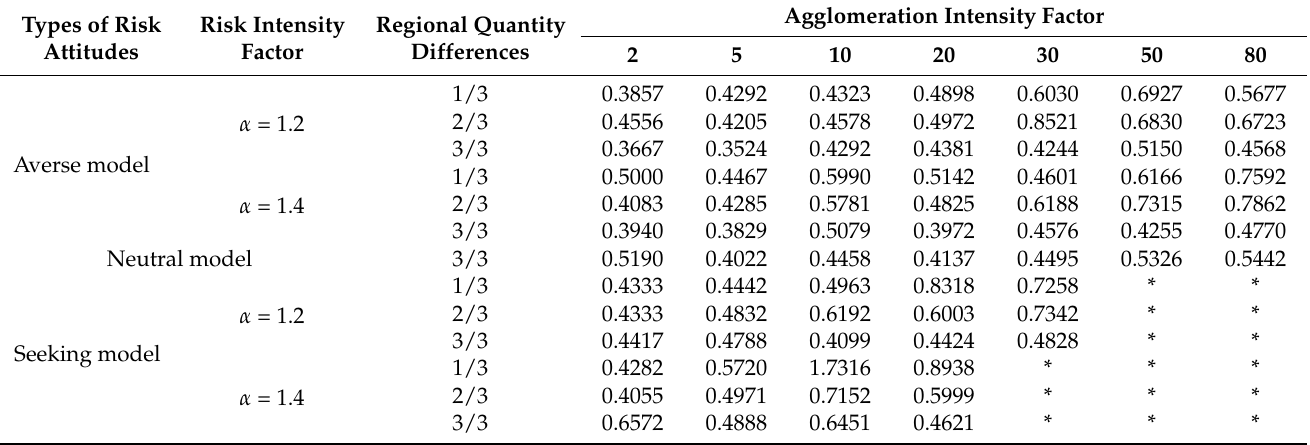
Table 4. Comparison of the primacy